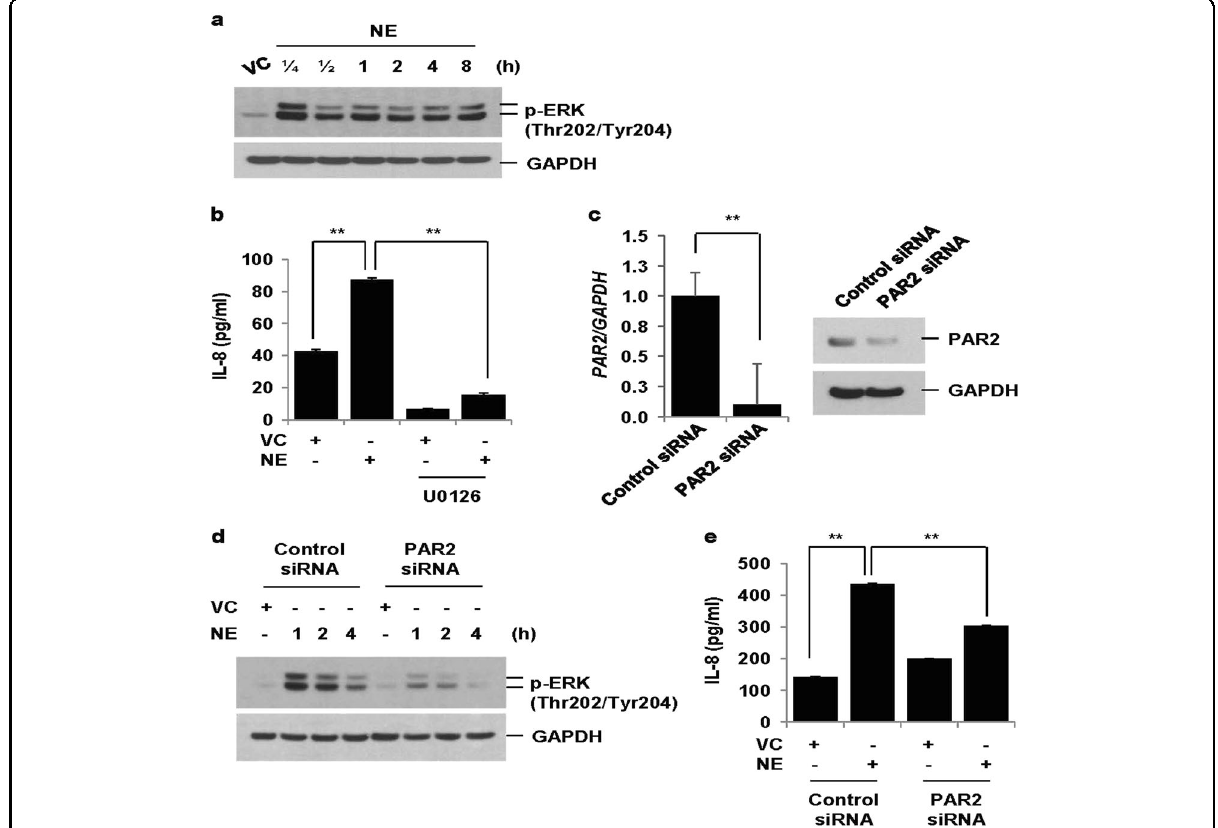
Fig. 1 NE increases IL-8 production via PAR2-mediated activation of ERK. a BEAS-2B cells were treated with vehicle control (VC) or NE (1 U/ml) for the indicated times. Total cellular extracts were subjected to western blot analysis for p-ERK and GAPDH. b Cells were pre-treated with an MEK inhibitor (U0126, 20 μ M) for 1 h and then stimulated with VC or NE (1 U/ml) for 24 h. Levels of IL-8 in cell supernatants were measured by multiplex bead assay. Data represent the mean ± SD; ** P < 0.05. c – e BEAS-2B cells were transiently transfected with control siRNAs or PAR2 siRNAs using a Neon electroporation kit. Forty-eight hours after transfection, cells were stimulated with VC or NE for 1, 2, 4 h ( d ) or 24 h ( e ). The expression of PAR2 was measured by quantitative real-time PCR. Data were normalized to the expression of GAPDH. Data represent the mean ± SD; ** P < 0.05. Total cellular extracts were subjected to western blot analysis for PAR2, p-ERK and GAPDH. IL-8 concentrations in culture media were measured by multiplex bead assay. Data represent the mean ± SD; ** P <